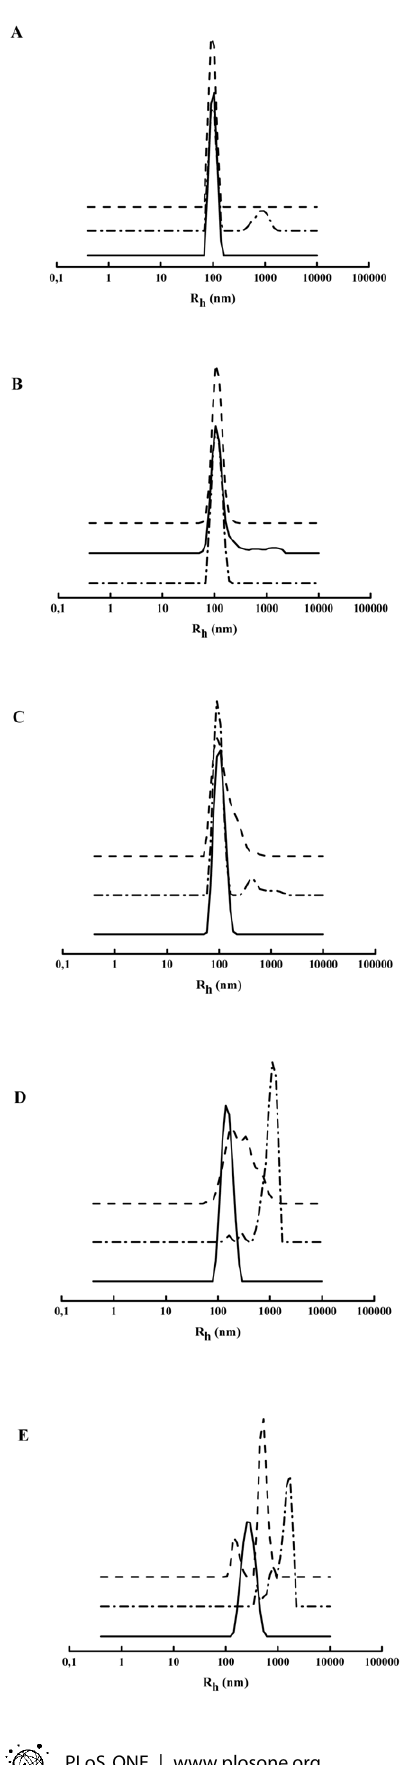
Figure 5. Dynamic light scattering of vesicles incubated with Ebola fusion peptide. (A) PC LUVs, (B) PC:PE:PI:Cho LUVs, (C) PC:PE:SPM:Cho LUVs, (D) lipid rafts from BHK-21 cells and (E) lipid rafts from Vero cells. All experiments were done in phosphate buffer pH 7 at 37 u C. The peptide concentration was 100 m M, and the liposome concentration was 1